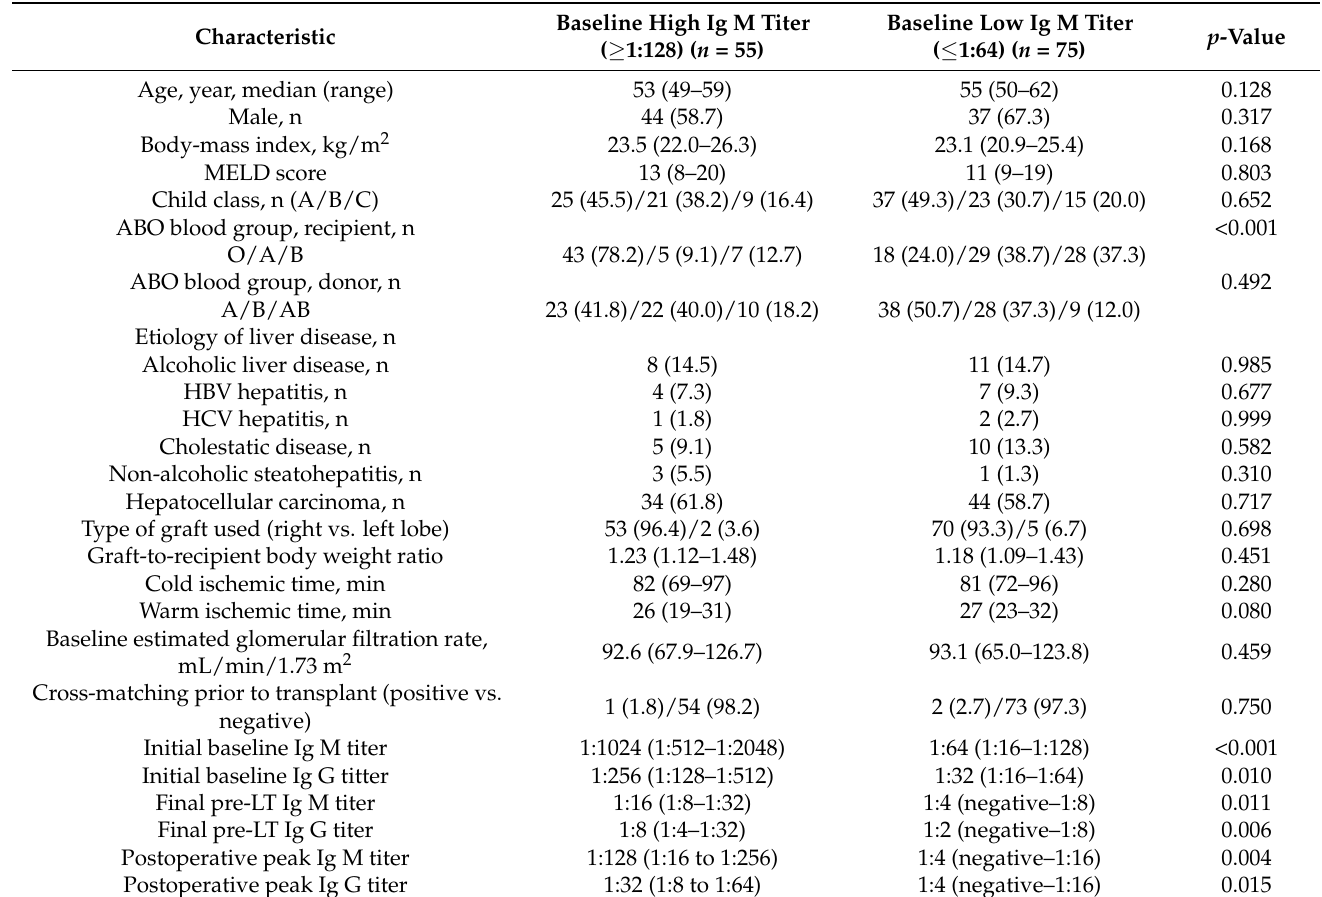
Table 1. Comparison of patient demographics and characteristics between patients with high and low initial baseline Ig M isoagglutinin